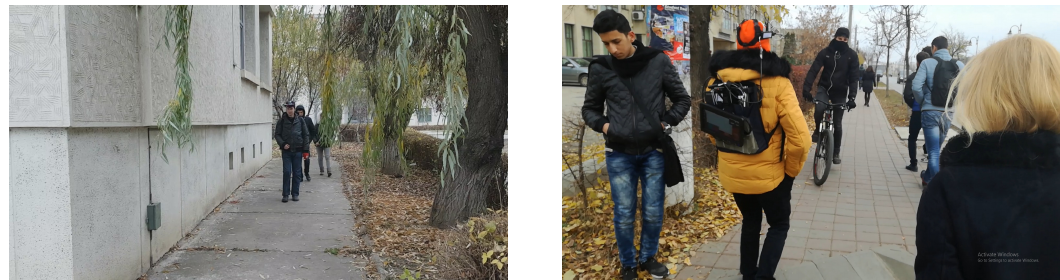
Figure 8. Examples of outdoor testing scenarios: ( left ) Semi-controlled environment, in which the test consisted in walking along a building wall while avoiding hanging and ground-level obstacles; ( right ) uncontrolled environment, in which the test consisting in walking on a crowded